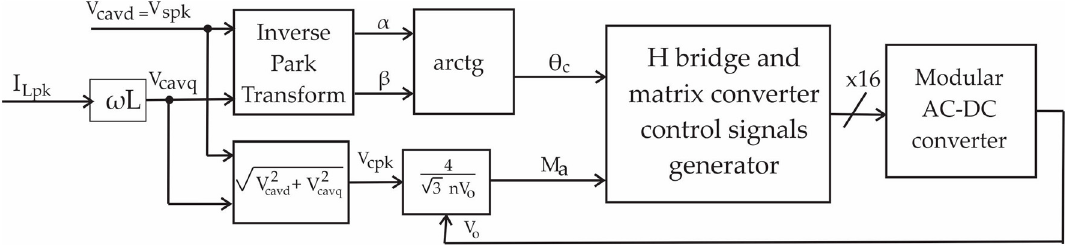
Figure 14. General scheme used in simulation.